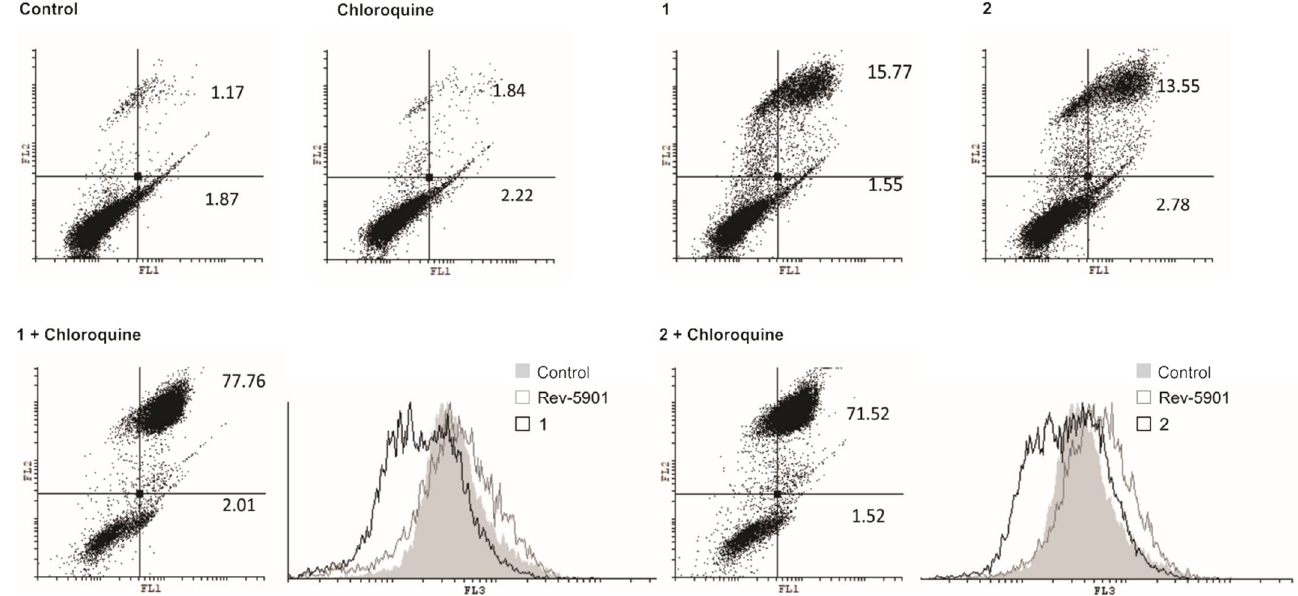
Figure 2. Autophagy has a cytoprotective role. CT26CL25 cells were incubated for 24 h with IC 50 doses of 1 and 2 in the presence or absence of the autophagy inhibitor chloroquine (10 μM and 20 μM); then, they were subjected to Annexin/propidium iodide double staining and acridine orange staining. Cells were analyzed by flow cytometry. One representative experiment out of three is shown.